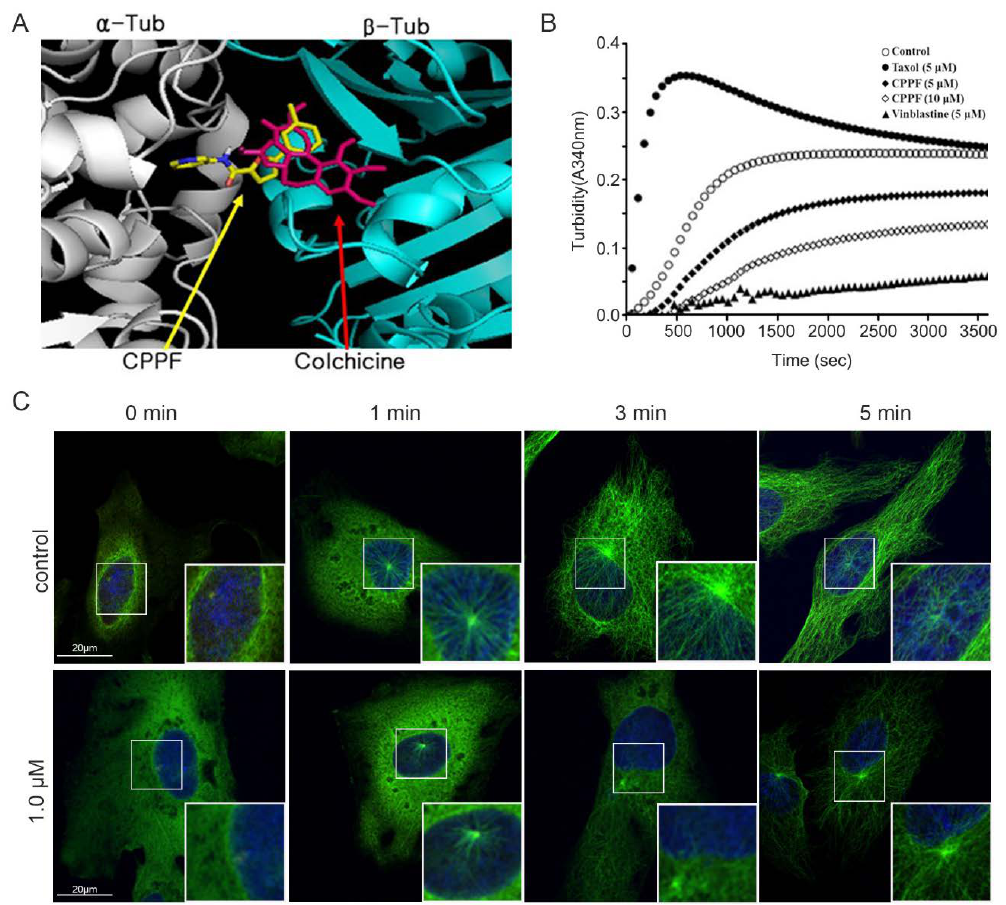
Figure 4. CPPF targets microtubules. ( A ) Computer modeling of the CPPF binding site on tubulin; ( B ) Bovine tubulin was incubated at 37 °C with or without compounds and time-dependently measured at 340 nM to track tubulin polymerization; ( C ) HeLa cells were treated with DMSO control or 1 µM CPPF. Then cells were incubated in ice-cold media for 30 min. After, the media was replaced with warm media and cells were time-dependently fixed using paraformaldehyde. Cells were stained with α - tubulin (green), γ -tubulin (red) and DNA (blue). Images were captured using a confocal